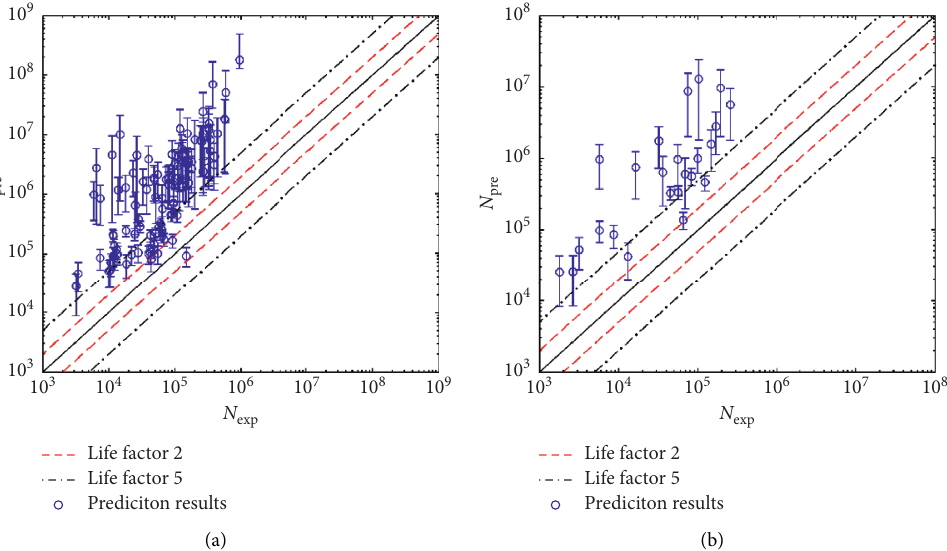
Figure 10: Fatigue life prediction results of the prior mean model in equation (7). (a) Steel bars with diameter of 12mm and (b) steel bars with diameter of